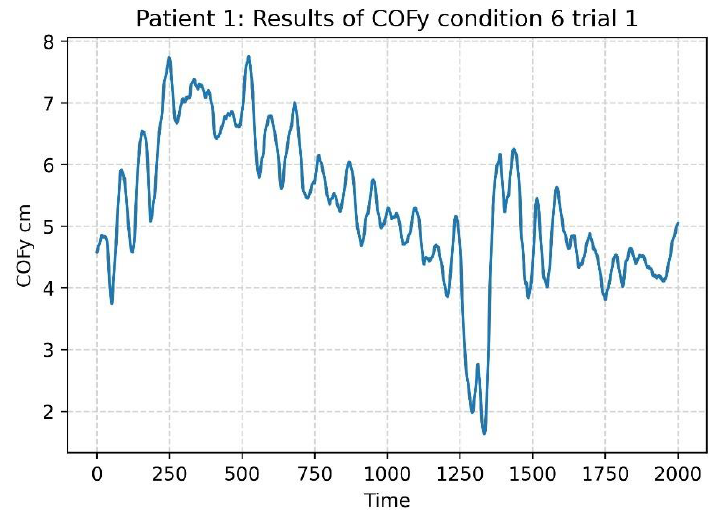
Figure 3. COPy time series for a patient for the test condition 6.